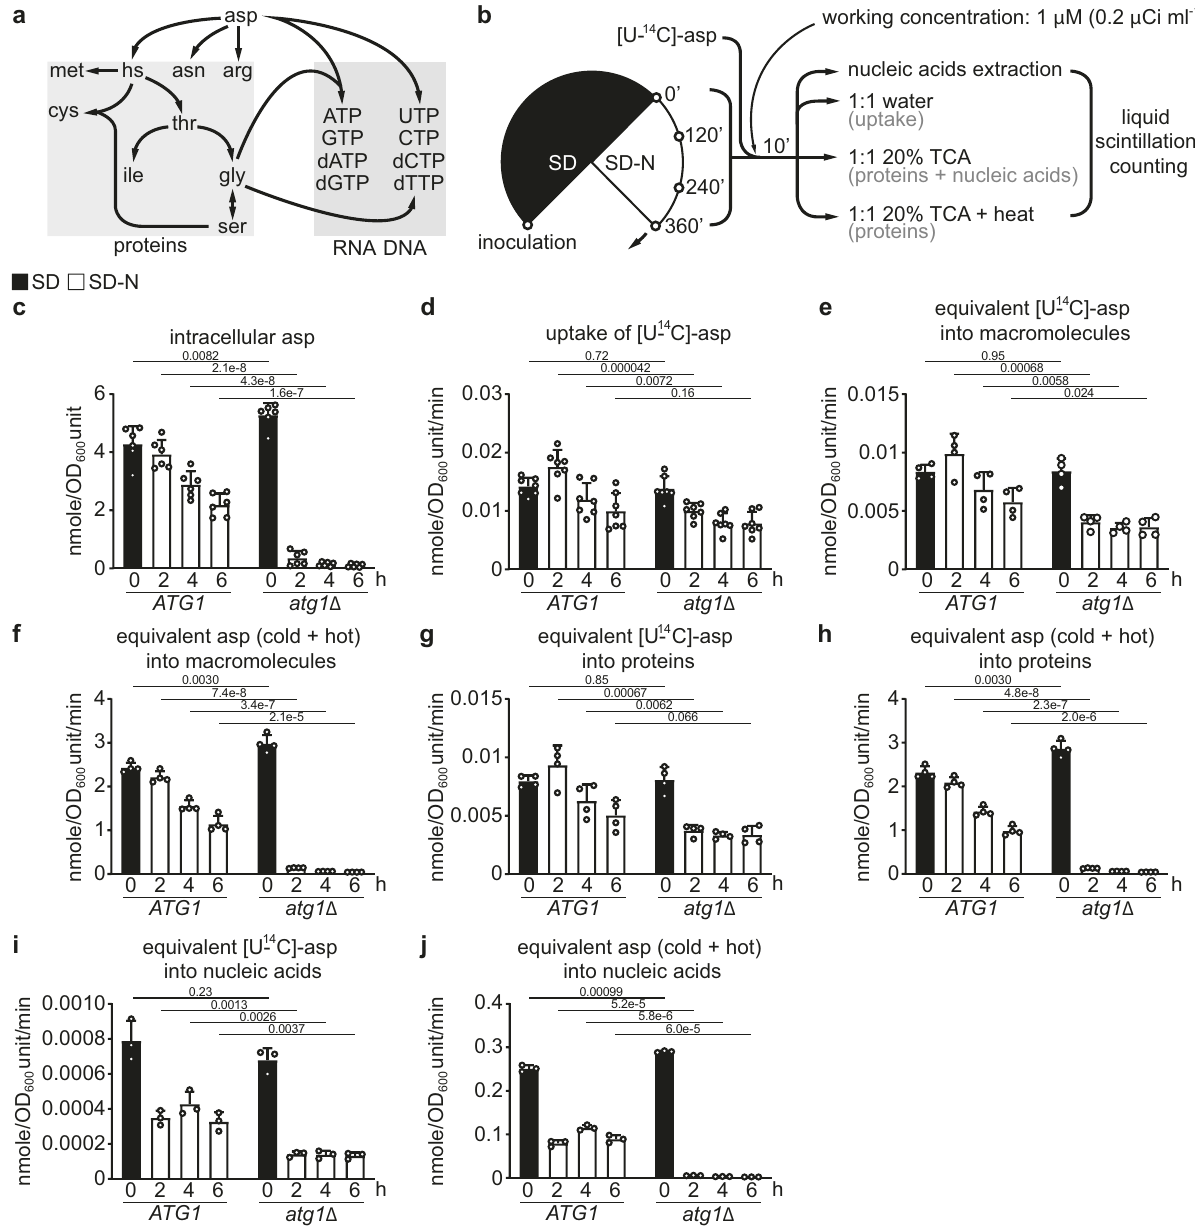
Fig. 7 Aspartate sustains macromolecule synthesis under nitrogen starvation. a Metabolic fate of aspartate in cellular anabolism. hs: homoserine. b Schematic of the experimental design for d , e , g , and i . c Estimation of intracellular aspartate concentration in WT ( ATG1 ) and atg1 Δ cells. Data were based on Fig. 1b and Supplementary Fig. 3b. Six independent replicates. d Uptake of [U- 14 C]-aspartate in WT and atg1 Δ cells. Seven independent replicates. e Incorporation of equivalents of [U- 14 C]-aspartate (aspartate and its derivatives) into macromolecules (proteins and nucleic acids). Four independent replicates. f Incorporation of total aspartate equivalents into macromolecules. Four independent replicates. g Incorporation of equivalents of [U- 14 C]- aspartate into proteins. Four independent replicates. h Incorporation of total aspartate equivalents into proteins. Four independent replicates. i Incorporation of equivalents of [U- 14 C]-aspartate into nucleic acids. Three independent replicates. j Incorporation of total aspartate equivalents into nucleic acids. Three independent replicates. P values were calculated using unpaired two-sided Student ’ s t test assuming equal variances. Data are presented as mean± standard deviation. glucose and 6.7 gl − 1 BD Difco yeast nitrogen base without amino acids) or starved in SD-N medium (20 gl − 1 glucose and 1.7g l − 1 BD Difco yeast nitrogen base without amino acids and ammonium sulfate) at 30 °C and 300 rpm. Metabolite extraction and detection . The extraction protocol comprised two sequential steps: quenching and extraction, which were originally published by Castrillo et al. 60 and Gonzalez et al. 61 , respectively. Quenching was achieved by mixing one volume of cell culture with three volumes of methanol – water solution (60% v/v, buffered with 10 mM Tricine to pH 7.4) kept at − 40°C. Quenched cells NATURE COMMUNICATIONS| (2021) 12:57